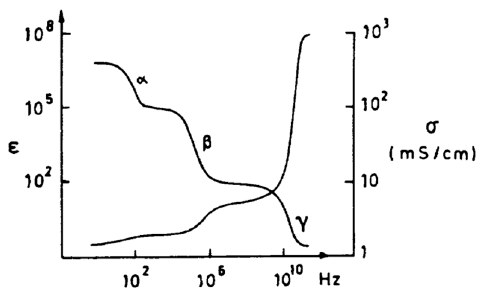
Figure 2. Dielectric constant and conductivity of bio-tissue in the frequency domain (taken from [7]).